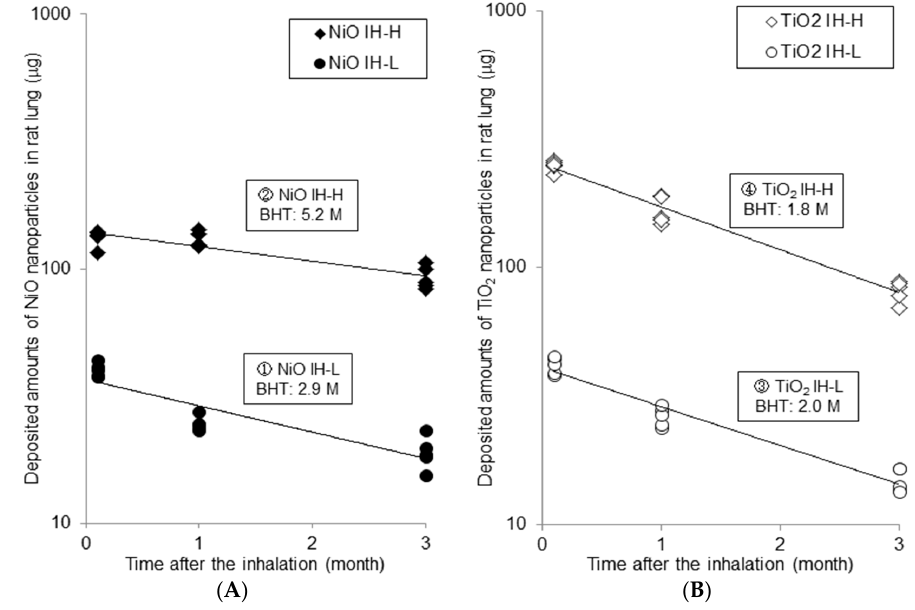
Figure 1. Biopersistence of NiO and TiO 2 nanoparticles in rat lungs in inhalation studies. ( A ) NiO nanoparticles; ( B ) TiO 2 nanoparticles.